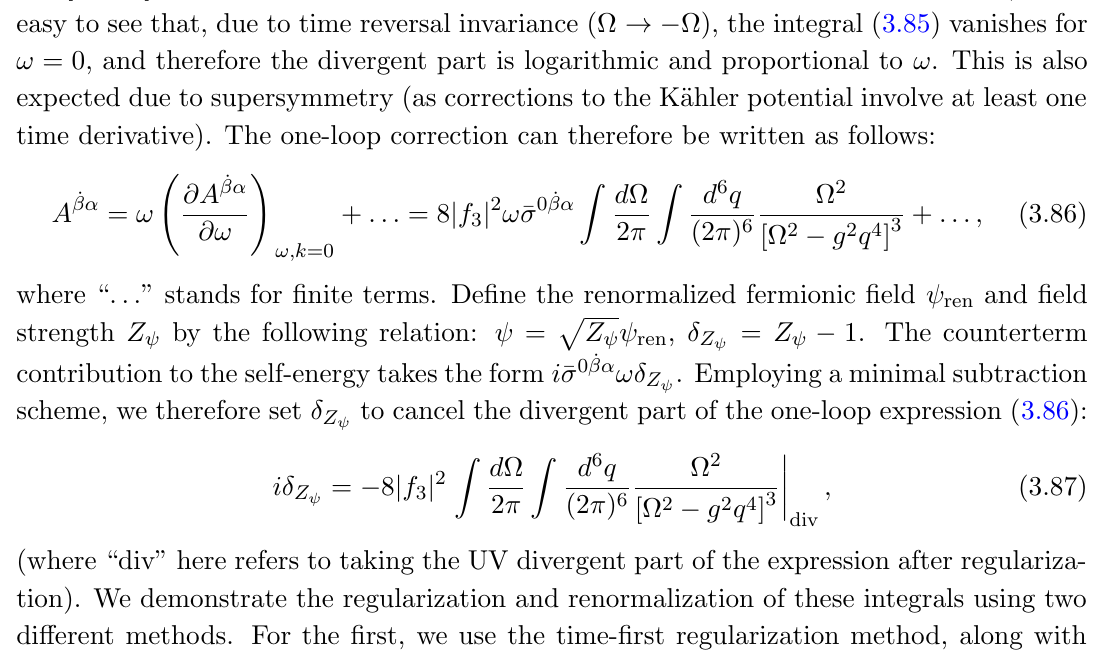
Figure 8 . The leading order quantum corrections to the fermionic propagator in the critical model of n = 3 interaction in 6 + 1